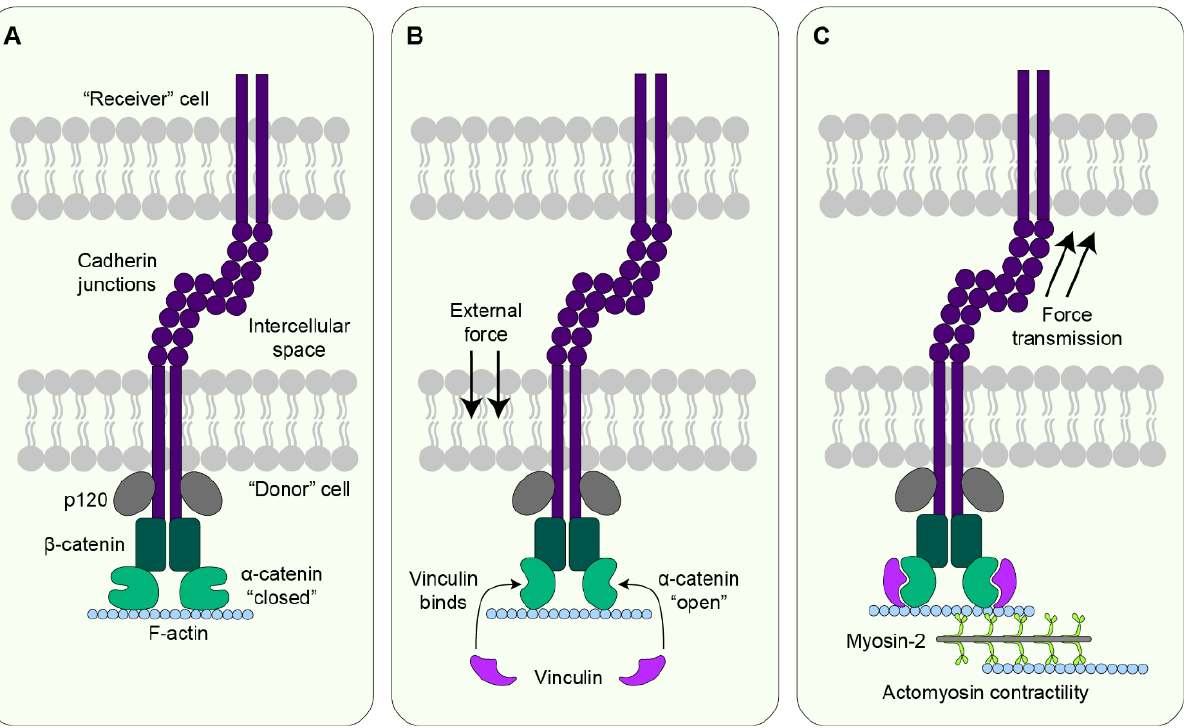
Figure 1. Mechanical force transduction at adherens junctions. Forces are transmitted through adherens junctions by cadherin dimers. The cytosolic tail of cadherin binds to p120 and β -catenin while the extracellular domain crosslinks with cadherin from the neighbouring cell. ( A ) In the absence of an external force, β - catenin is bound by α - catenin in its “closed” conformation to form the α -catenin- β -catenin- cadherin complex. In the “closed” state the vinculin - binding site on α -catenin is not accessible. ( B ) When the cell experiences a force, α -catenin undergoes a conformation change into the “open” state, thereby unmasking the vinculin-binding site and leading to vinculin recruitment at the junctions [10,11]. ( C ) Following vinculin recruitment, intracellular forces are generated by actomyosin contractility due to the movement of myosin head domains on F-actin filaments [12,13]. The cell that generates contractile forces acts as a force donor, and force is transmitted to the receiver cell via the junctions, thereby exerting pulling forces on the receiver cell. In addition to acting as a downstream responder to external forces, actomyosin contractility itself generates forces which act on cadherin junctions and elicit cadherin mechanotransduction in the receiver cell.